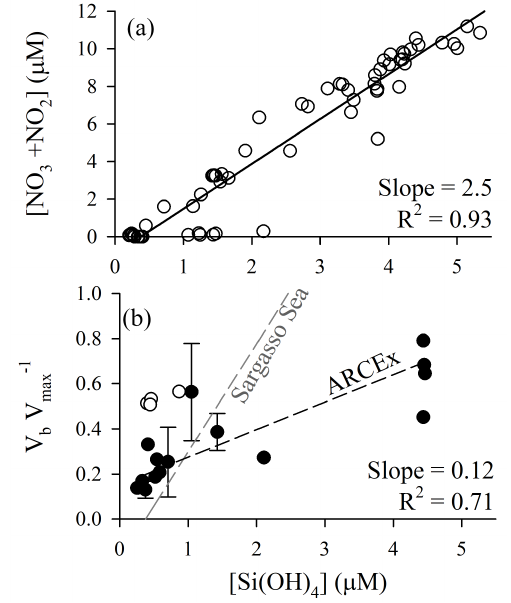
Figure 5. Diagnosis of potential silicon limitation for diatom pro- duction during ARCEx. (a) Nitrate + nitrite drawdown as a function of dissolved silicic acid. (b) The ratio of V b at ambient [Si ( OH ) 4 ] to V max versus dissolved silicic acid. In both panels, linear regres- sions were done using a model II reduced major axis method; for panel (b) the regression line does not include the Hornsunddjupet station (open circles). For comparison, the same relationship for the Sargasso Sea in the North Atlantic subtropical gyre is shown, as synthesized in Krause et al.